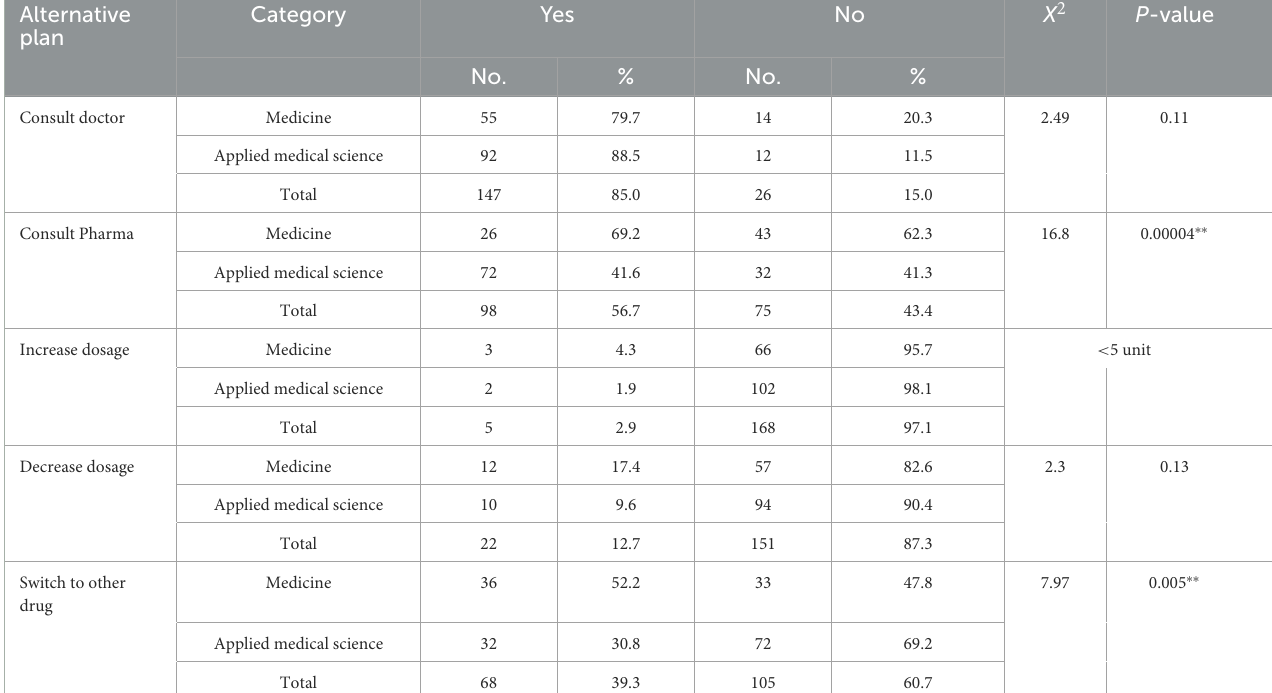
TABLE 6 Alternative plan if adverse effect of SM ( N = 173).